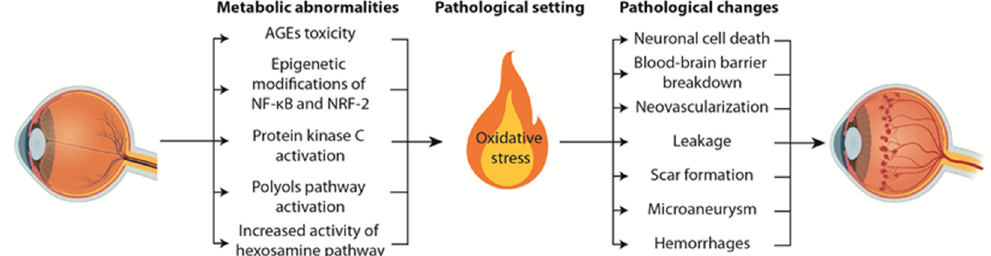
Figure 1. Hypothetical model of metabolic abnormalities associated to DR. Hyperglycemia disturbs essential molecular pathways involved in retinal homeostasis. These metabolic abnormalities lead to pathological changes in retinal tissues that ultimately cause DR. This figure does not describe the chronological order of the metabolic abnormalities or the pathological changes, instead it demonstrates that different metabolic abnormalities could happen at the same time.